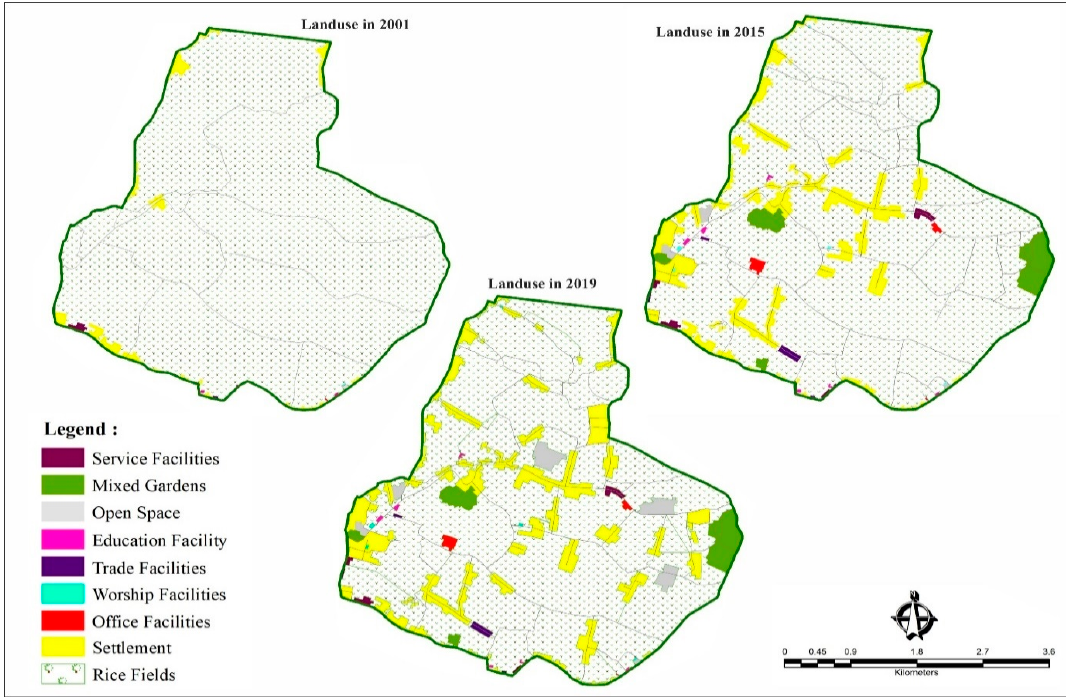
Figure 8. Change to Land Use in the Moncongloe-Pattalassang Suburbs. Source: author elaboration, Map © 2001, 2015, 2019 Google. Table 3. Change to Land Use in the Hertaning-Samata